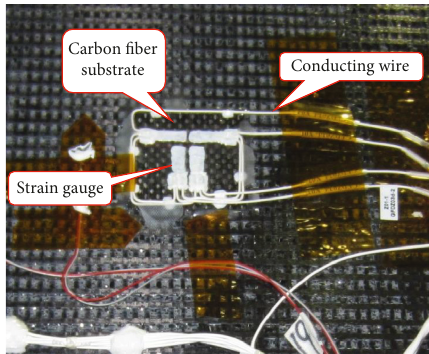
Figure 5: On-site picture of the designed measurement apparatus stuck to the solar array surface.